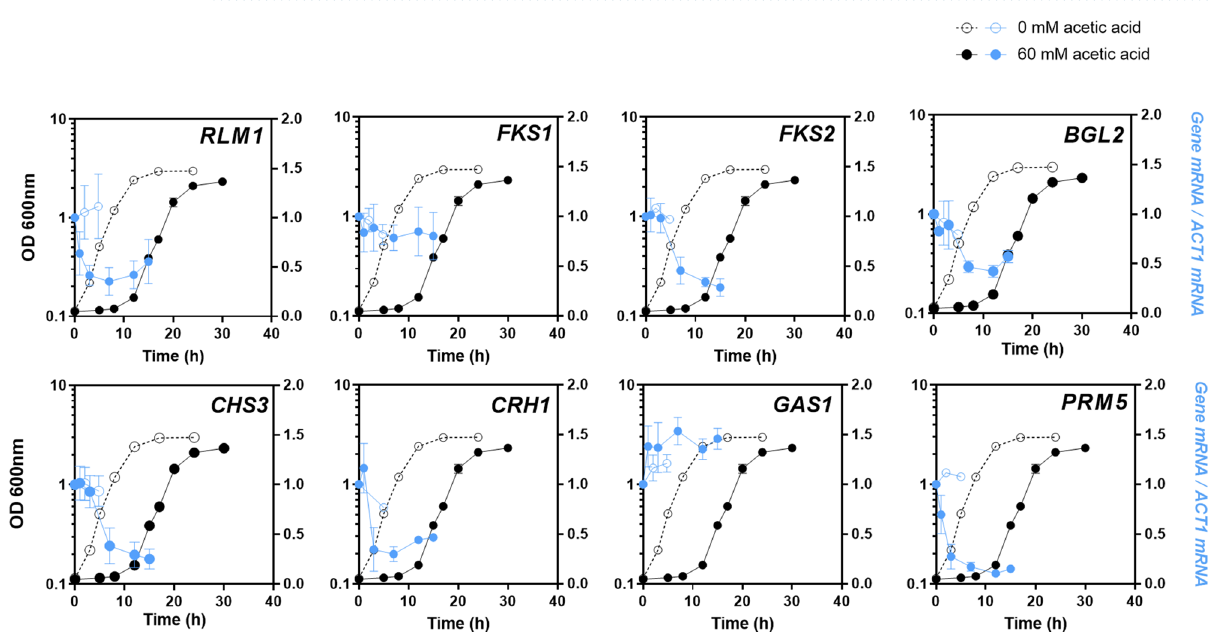
Figure 3. Levels of mRNA from cell wall biosynthesis-related genes during yeast cultivation in the absence or presence of acetic acid. Time-course of the mRNA levels from RLM1 , FKS1 , FKS2 , BGL2, CHS3 , CRH1, GAS1 and PRM5 genes during cultivation of BY4741 in absence (open circle) or presence (filled circle) of acetic acid, as described for Fig. 1. The transcriptional levels (in blue) from the indicated genes were assessed by qRT-PCR, using ACT1 as the internal control. The relative value obtained for each target gene at the initial time-point under unstressed conditions was set as 1. Results are means of, at least, three biological replicates and error bars represent standard deviation. Primers were designed using Primer Express V3.0 (Applied